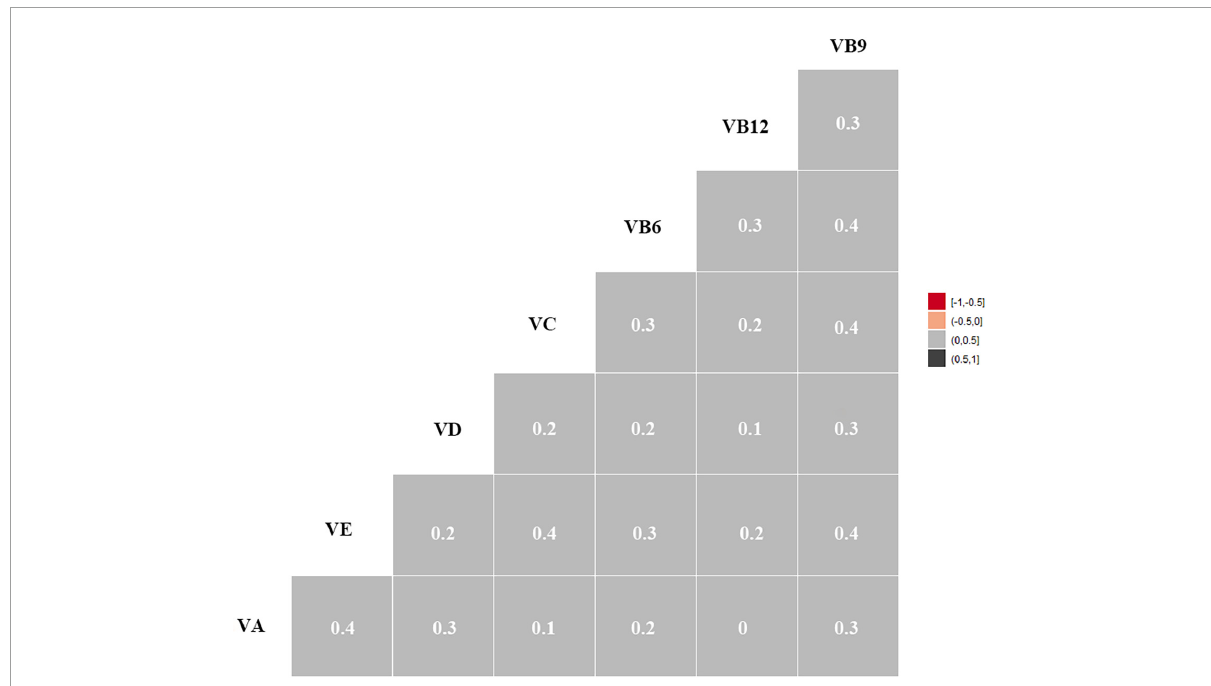
FIGURE2 Heat Map for Spearman correlation between serum vitamins. Correlation intensity between two vitamins was indicated by square color. In the heat map, the black color shows a strong positive expression correlation, whereas the gray color depicts a weak expression correlation. VA, vitamin A; VE, vitamin E; VC, vitamin C; VD, vitamin D; VB6, vitamin B6, VB12, vitamin B12; VB9, vitamin